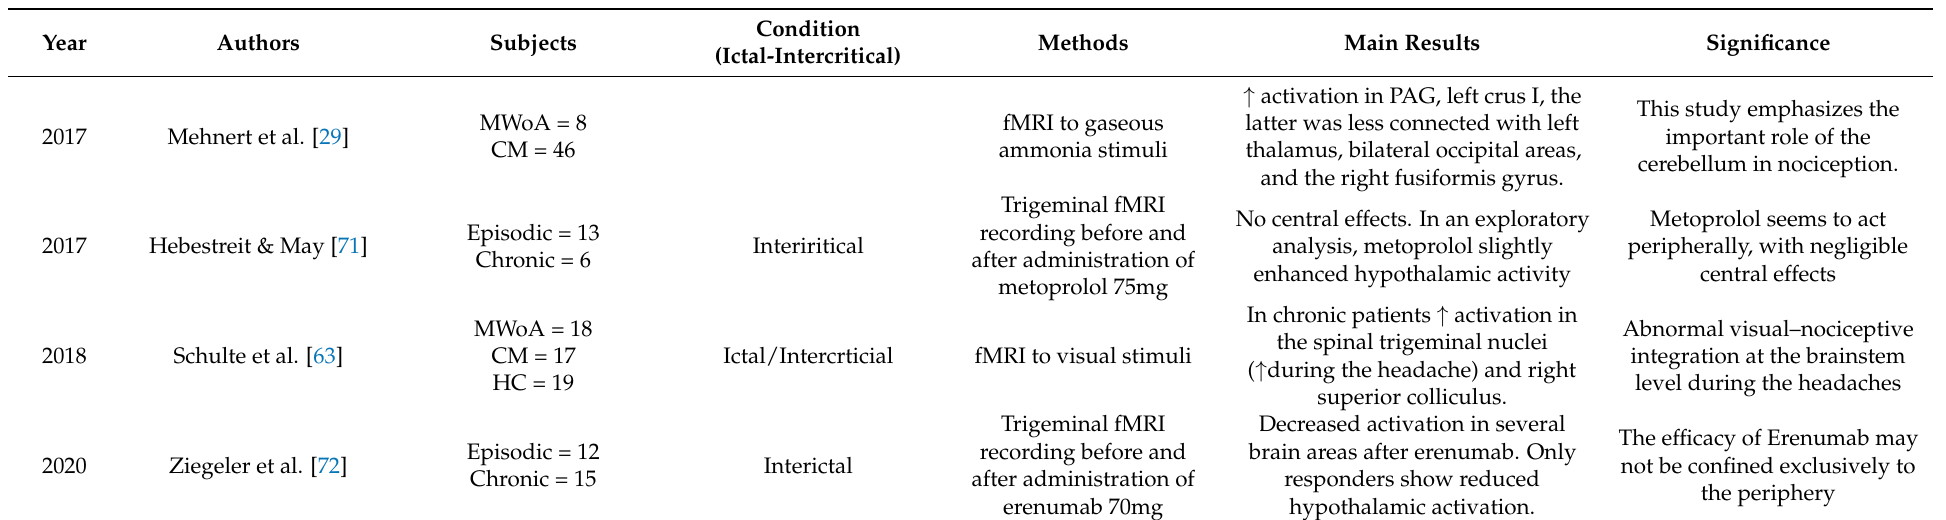
Table 2. FMRI case control connectivity studies employing pain-related